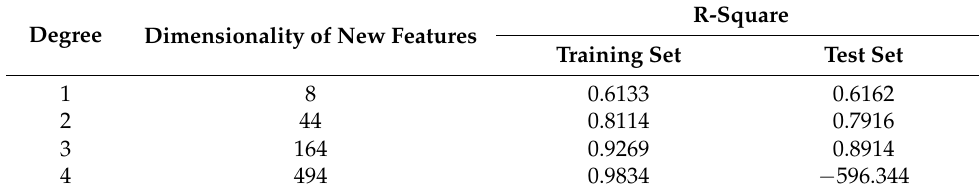
Table 3. Result of LR model with different polynomial features.